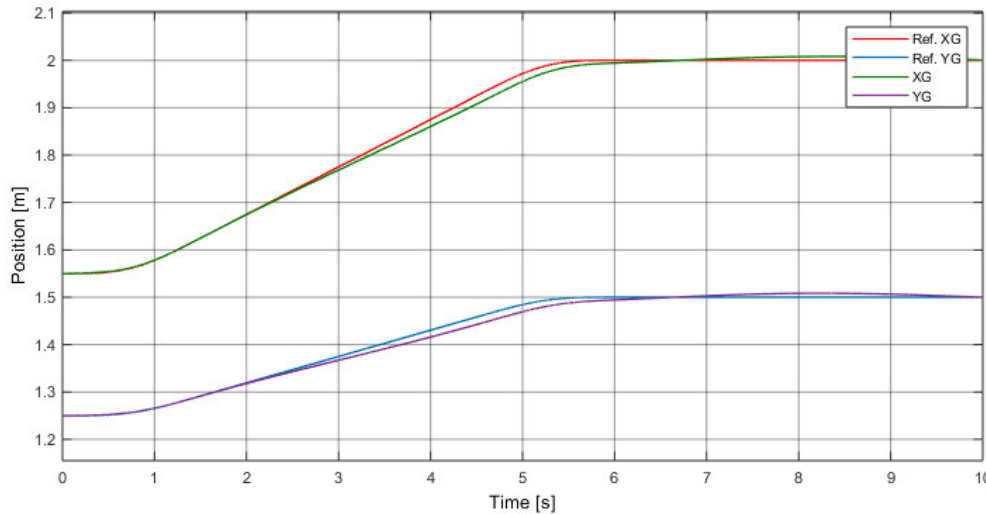
Figure 21. Planar CDPR positioning response of a PID controller.